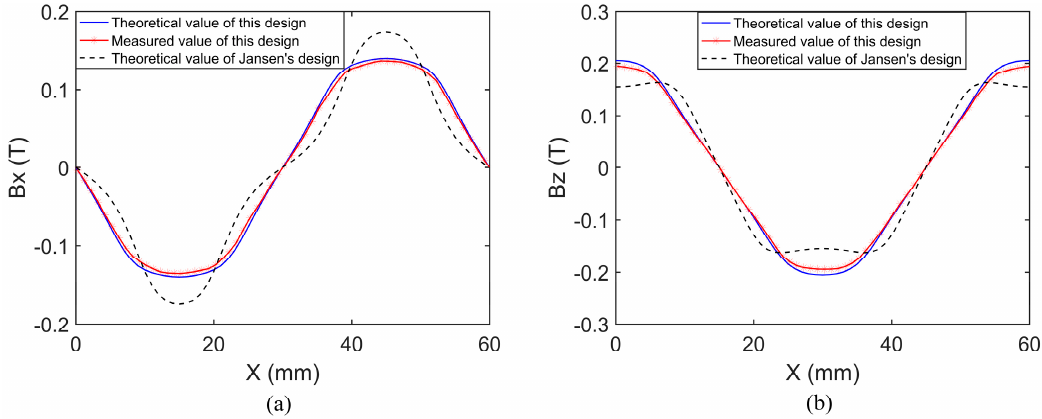
Figure 8. Magnetic flux density distributions of this design and Jansen’s design. ( a ) The m x -component of flux density; ( b ) the m z -component of flux density.